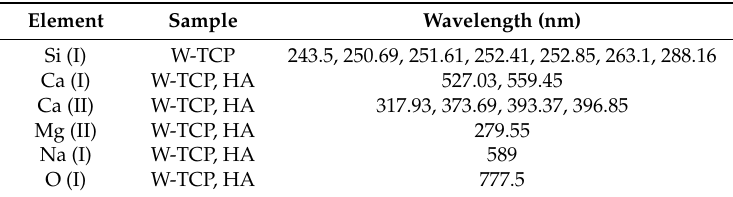
Figure 1. Comparative LIBS spectra between the W-TCP eutectic glass and the layer produced on the surface of the sample ( a ). The spectra shown are the average of 10 shots with an integration time of 3 ms. The HA LIBS spectrum is also presented for comparison purposes ( b ). Table 1. List of the main spectral lines observed in the samples.